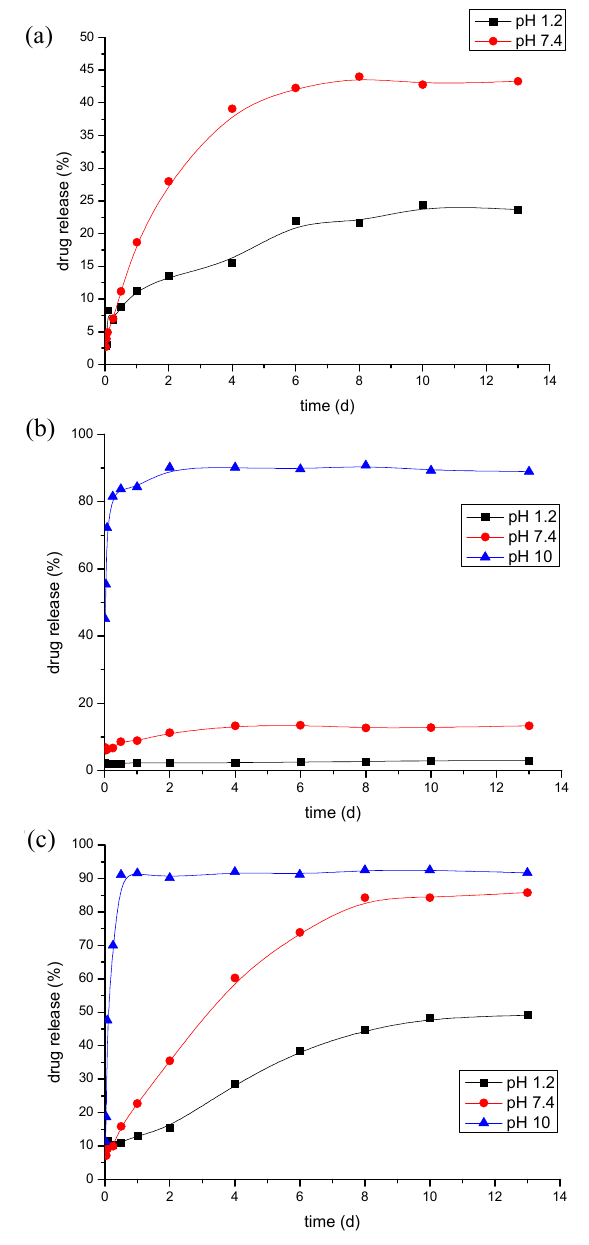
Figure 2. Release profiles of ketoprofen from polyester in different solution (pH 1.2, 7.4 and 10.0) at 37 °C. ( a ) Polyester 3a ; ( b ) Polyester 3b ; and ( c ) Polyester 3c